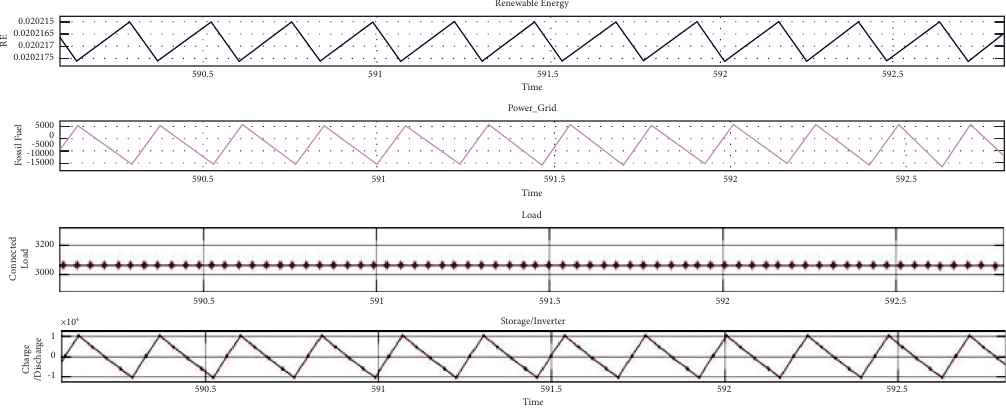
Figure 5: Experiment